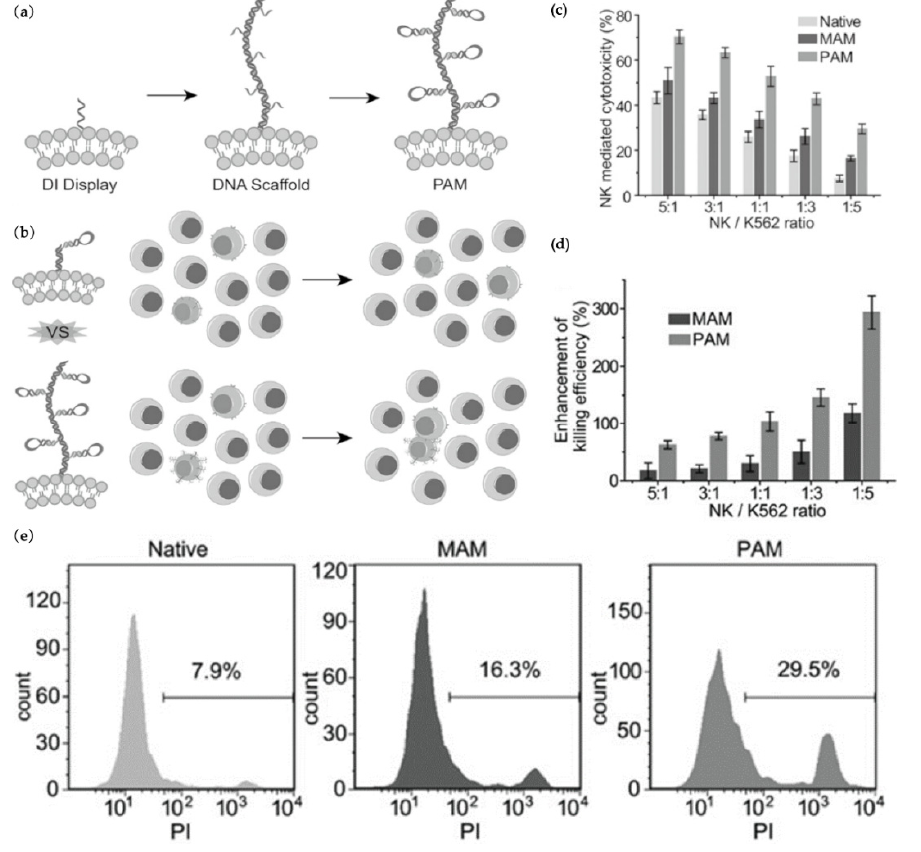
Figure 6. ( a ) In situ synthesis of PAMs on the cell surface through DNA initiator (DI) display, scaffold construction, and polyvalent hybridization; ( b ) comparison between the PAM and monovalent antibody mimic (MAM) for recognizing target cancer cells; ( c ) effect of the NK/K562 ratio on the cytotoxicity of K562 cells; ( d ) enhancement of the killing efficiency; ( e ) representative flow cytometry histograms taken at a 1:5 effector/target ratio. Reprinted with permission from Ref. [41]. Copyright 2020 John Willey and Sons.